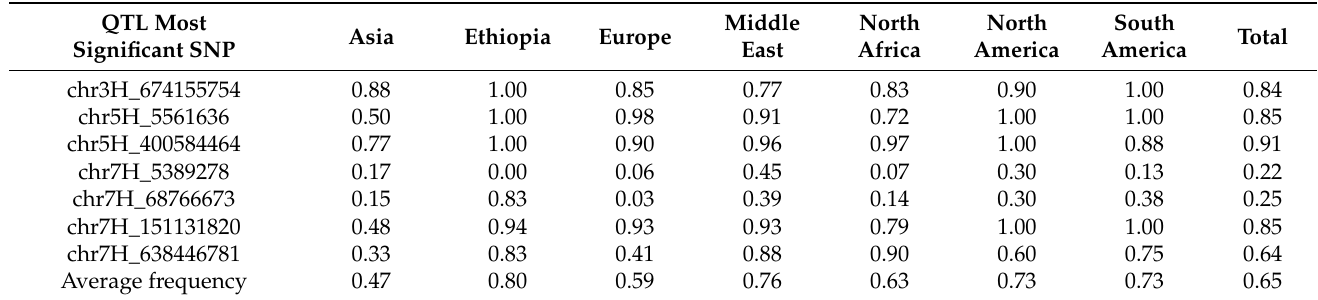
Table 4. Frequencies of the alleles associated with resistance, for the QTL most significant SNPs, across geographical regions of origin of the landraces.